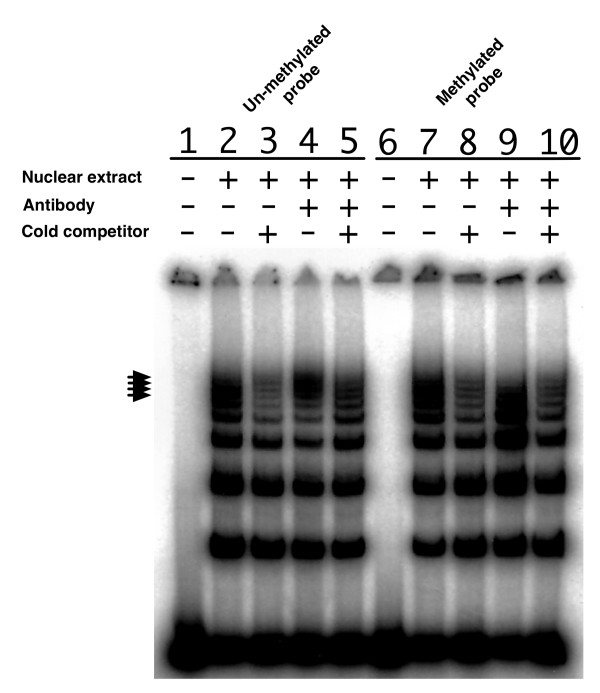
Specific binding of p53 to IGFBP-3 promoter and its inhibition by methylation. 2 ng of end-labelled 278 bp of Mlu I-Bgl II fragment of pGL-210 were used for EMSA. To construct the methylated probe, a labelled fragment was methylated in vitro with Sss I methylase. Each reaction contained the components listed in Materials and Methods. 2.5 μg of H2O2-treated MCF7 with an induced p53 expression was used as nuclear extract. Supershift was obtained using 0.1 μg of anti-p53 (Ab-2). As competitor, 200 ng of the fragment that carries the core p53 binding site (-210/-149) were used. The mixture was incubated at room temperature for 20 min and analyzed on 4 % nondenaturating polyacrylamide gel in 0.5 × Tris-Glycine buffer. Supershift bands observed in lane 4 were indicated by arrows.